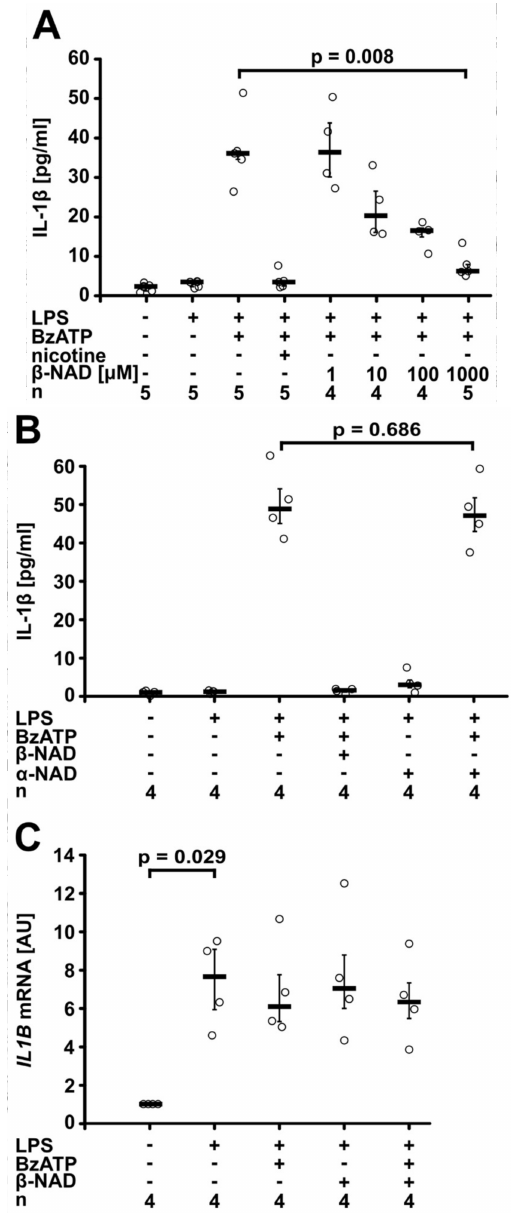
Figure 1. β -nicotinamide adenine dinucleotide ( β -NAD) inhibits ATP-induced IL-1 β release by U937 cells. ( A , B ) Human monocytic U937 cells were primed with lipopolysaccharide (LPS) (1 µ g/mL, 5 h) and stimulated with 2 (cid:48) (3 (cid:48) )- O -(4-benzoylbenzoyl)adenosine-5 (cid:48) -triphosphate (BzATP; 100 µ M, 30 min). The concentration of IL-1 β in the cell culture supernatant was measured by ELISA. ( A ) β -NAD dose-dependently inhibited the BzATP-induced release of IL-1 β (IC 50 = 15 µ M). Nicotine (10 µ M) was included as a positive control. ( B ) In contrast to β -NAD (1 mM), α -NAD (1 mM) was ineffective. ( C ) Real-time RT-PCR was performed to measure the mRNA expression of pro-IL-1 β ( IL1B ). The house-keeping gene HMBS was included for normalization, data are normalized to the values of untreated U937 cells and are expressed as arbitrary units (AU). Data are presented as individual data points, bars indicate median, whiskers encompass the 25th to 75th percentile, Kruskal-Wallis test followed by the Mann-Whitney rank sum